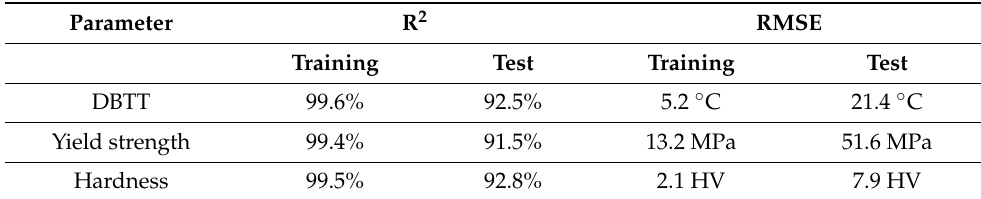
Table 6. Correlation coefficients and root mean square errors for the estimation of DBTT, mechanical hardness, and yield strength of 15Kh2NMFA